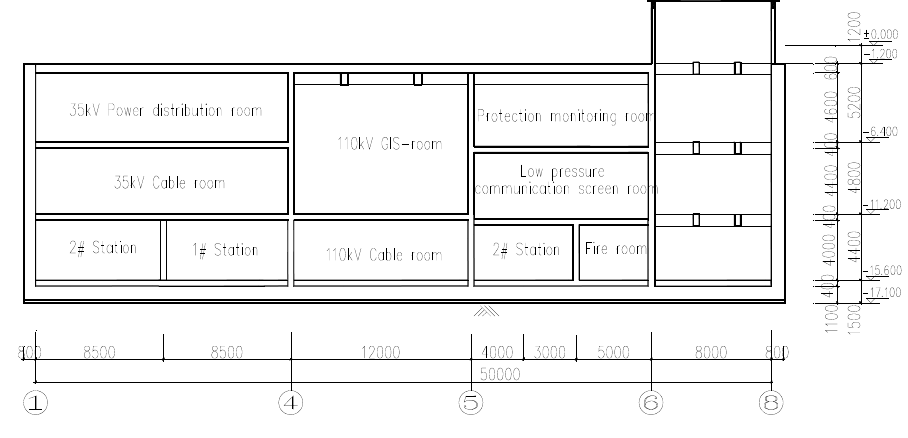
Figure 3. Long cross-section.